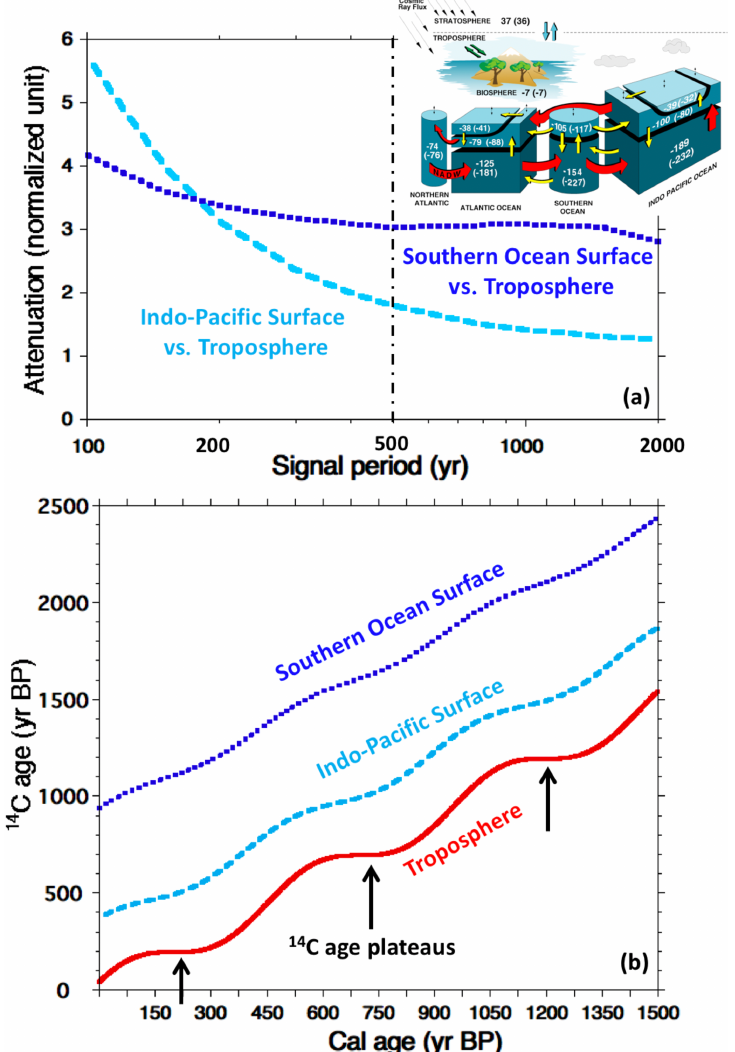
Figure 4. (a) Amplitude ratio of (cid:49) 14 C wiggles in the atmosphere and the surface ocean created by sinusoidal changes of the 14 C production as an input to the 12-box model shown in the upper insert (Bard et al., 1997). This normalized attenuation factor is plotted versus the signal period of production variations (on a log scale). The greater the attenuation, the more the amplitude of the sinusoid in the surface ocean is reduced. The factor would be equal to 1 if atmospheric and oceanic amplitudes were the same. The dashed light blue curve shows the calculation results for the Indo-Pacific surface box, while the dotted dark blue line stands for the Southern Ocean surface box. These two boxes differ by their surface 14 C reservoir age at steady state (320 and 890 years for the Indo-Pacific and Southern Ocean surface boxes, respectively). The vertical dash-dotted black line underlines the 500-year period wiggle used to construct panel (b) . The inset graph shows the geometry of the model by Bard et al. (1997) with numbers on boxes indicating their steady-state (cid:49) 14 C (‰), numbers in parenthesis stand for halving the meridional overturning circulation (MOC). Note that the main goal of the simulations in Fig. 4 is to demonstrate that age plateaus almost disappear and are delayed in the surface ocean due to the smoothing effect of the carbon cycle, even if it stays strictly constant. These simulations are not intended to simulate 14 C and MRA changes due to variations of the ocean circulation. On this subject, it should be noted that part of the simulations presented by Goslar et al. (1995) and mentioned in Sect. 2.3 and 2.8 were obtained with the very same box model used for our simulations but with a variable MOC. (b) 14 C age versus calendar age plot computed for sinusoidal 14 C production wiggles with a period of 500 years and an amplitude change of ± 15% around the mean value (in order to produce oscillations around the 1:1 line, 14 C ages are calculated with the true half-life of 5730 years). The solid red curve shows the evolution for the tropospheric box, exhibiting 14 C plateaus (marked with black arrows) when the slope of the relationship goes down to zero. The age plateau corresponds to the second part of the atmospheric (cid:49) 14 C wiggle, during which the (cid:49) 14 C decrease compensates the radioactive decay. The dashed light blue curve shows the calculation results for the Indo-Pacific surface box, while the dotted dark blue line stands for the Southern Ocean surface box. The blue curves are offset with respect to the atmospheric curve by their respective marine reservoir ages. In both cases, the slope of the relationship does not decrease to zero, implying the absence of true 14 C age plateaus in the surface